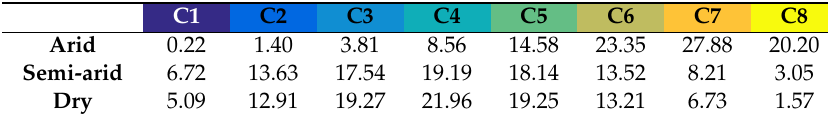
Table 4. Area of pGDV clusters occurring in each aridity class (% of the area of each aridity class). The likelihood of being GDV increases from C1 to C8.